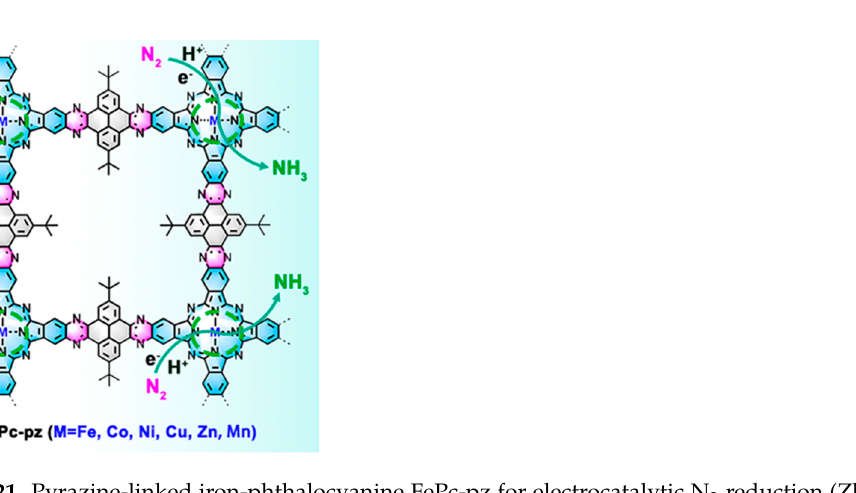
Figure 21. Pyrazine-linked iron-phthalocyanine FePc-pz for electrocatalytic N 2 reduction (Zhong H. et al., 2021) [185].